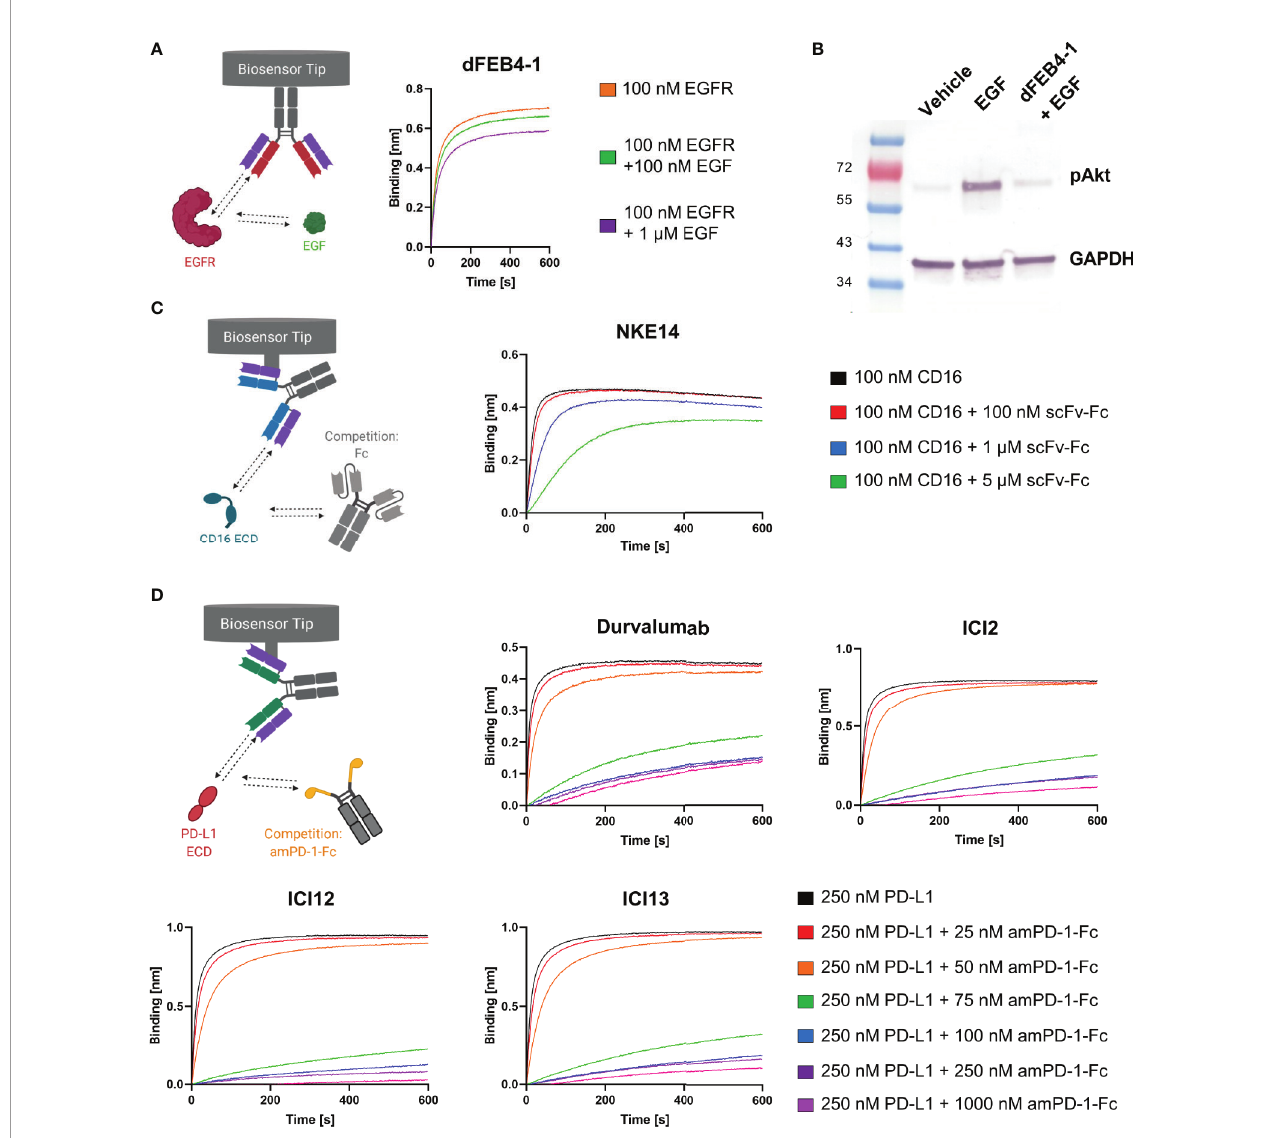
FIGURE 3 | Ligand-receptor blockage of isolated cLC-mAbs. (A) BLI-assisted EGF-inhibition assay. Immobilized dFEB4-1 binds to EGFR at different EGF concentrations, revealing a dose-dependent binding. (B) Western blot analysis of inhibition of EGF-induced phosphorylation of AKT in A549 cells. 50 µg/mL dFEB1-4 and 10 ng/mL EGF were utilized. The western blot was performed three times, yielding reproducible results. (C) Epitope determination of NKE14. Immobilized NKE14 binds to CD16a at different scFv-Fc concentrations. CD16a:Fc-binding led to diminished binding of NKE14 to CD16a in a dose-dependent manner. (D) PD-1:PD-L1 interaction inhibition assay. Immobilized ICI2, ICI12, ICI13, or durvalumab binding to PD-L1 at different amPD-1-Fc concentrations, revealing dose-dependent